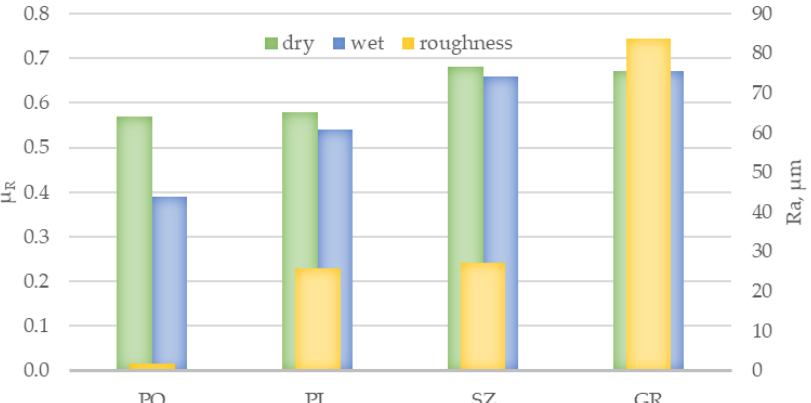
Figure 10. Results of dynamic friction coefficient ( µ R ) of PO, PL, SZ, and GR granite slabs, determined in dry and wet conditions using a set of rubber sliders against the background of surface roughness expressed by Ra .